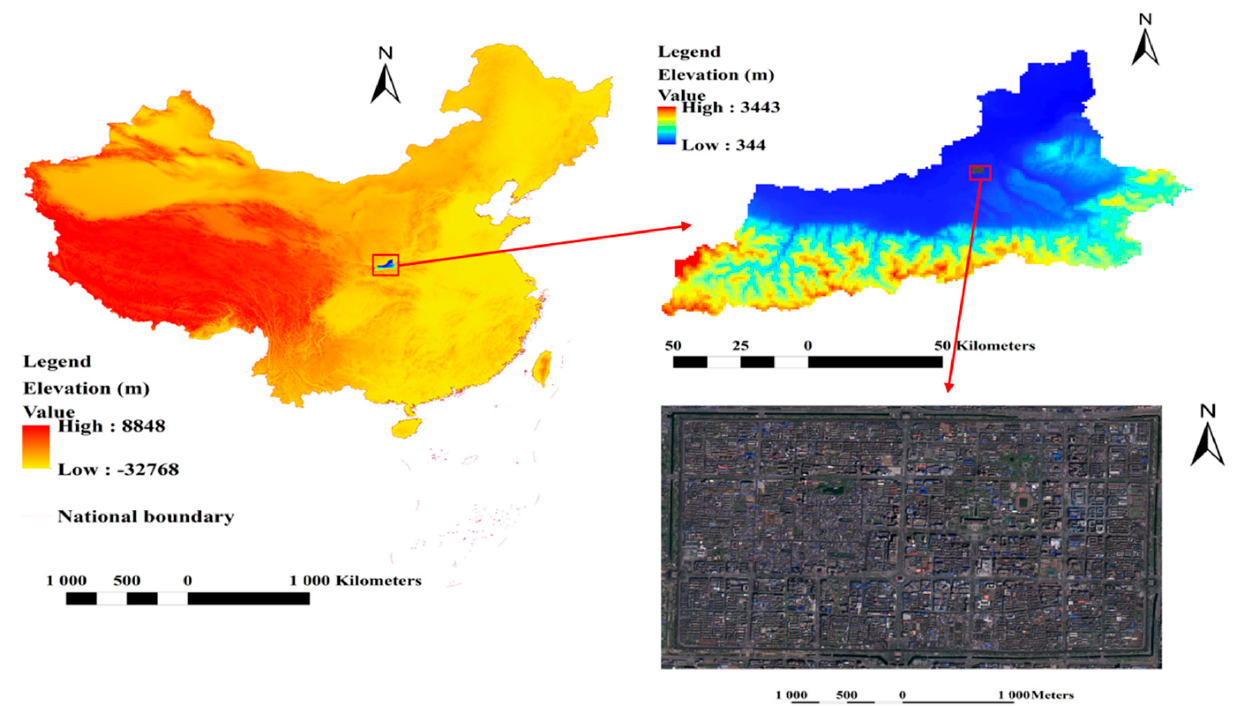
Figure 1. Location and remote sensing image of the study area.